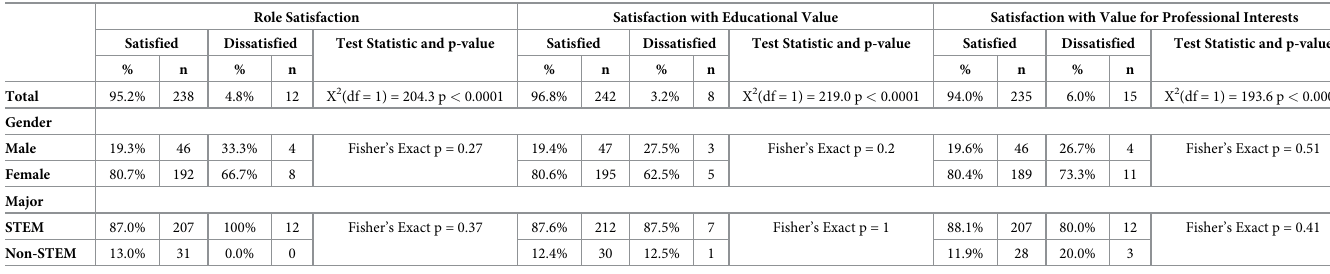
Table 3. Comparing gender and major to satisfaction.